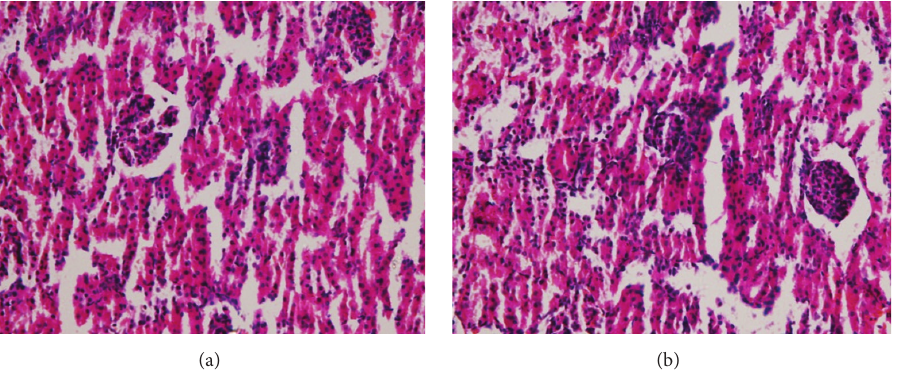
Figure 2: (a) Treated kidney. (b) Control kidney.